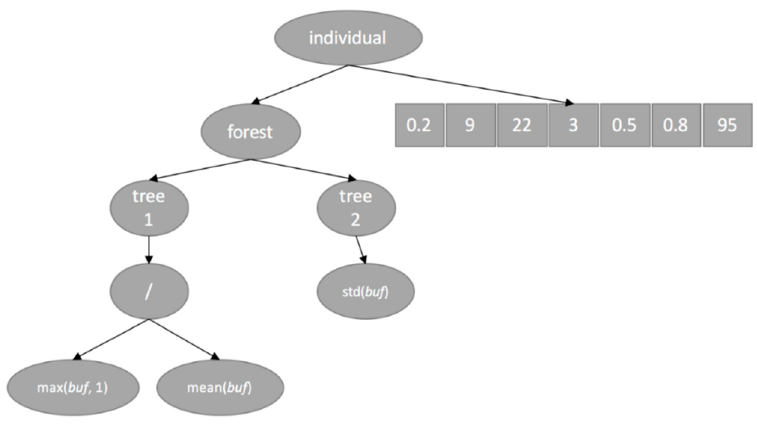
Figure 6. Example of the individual.